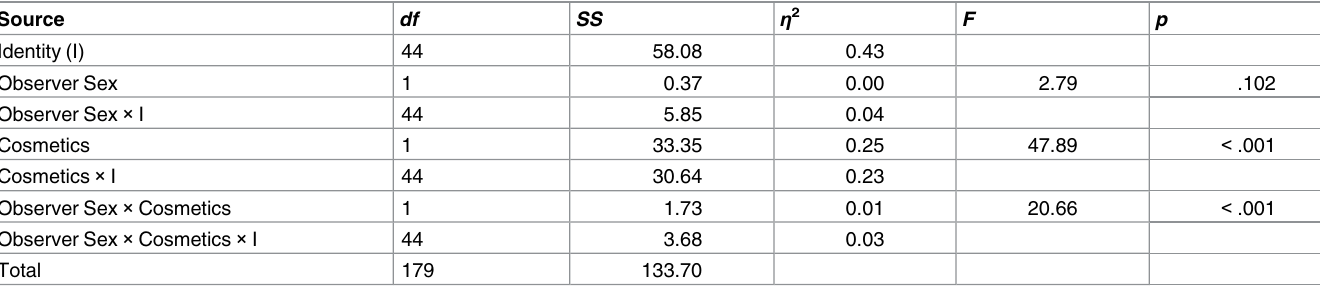
Table 2. Results of the analysis of variancefrom Study 2.